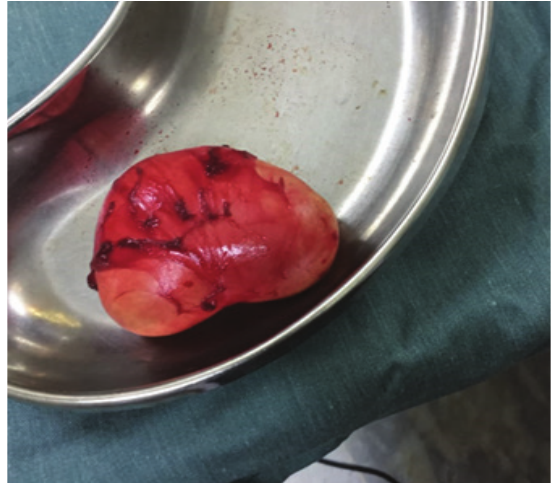
Figure-III: Excised